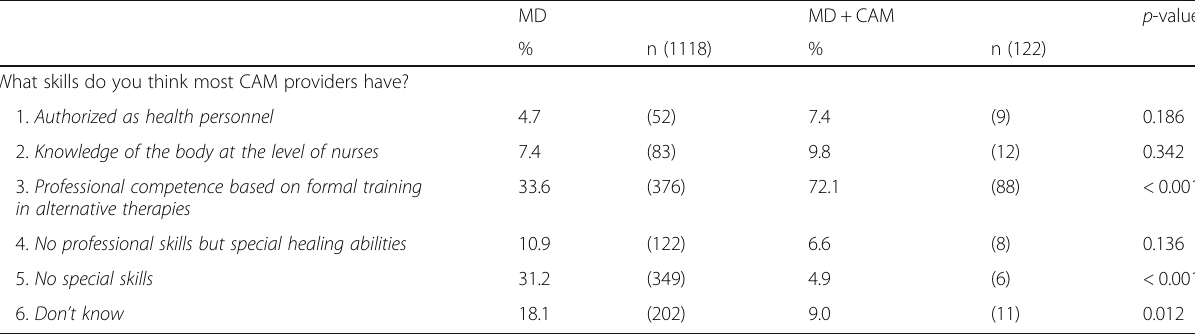
Table 2 Expected skills of CAM providers a